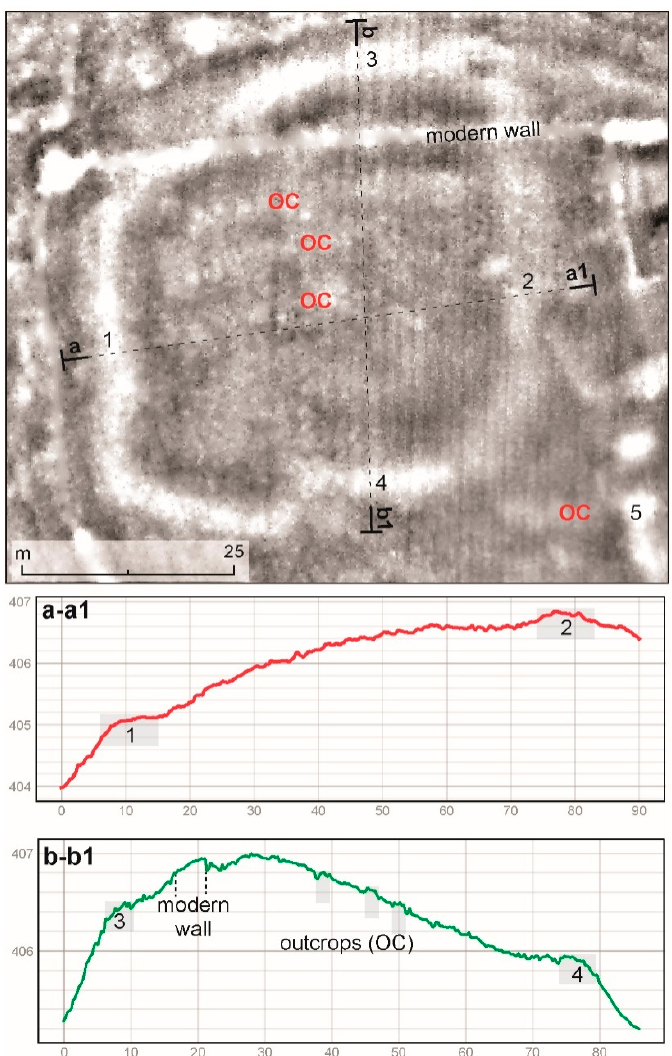
Figure 7. Simple Local Relief Model visualization of feature 10 ( top ) and interpreted profiles ( below ) (radius = 20 px). The dotted lines and associated letters a-a1 and b-b1 indicate the position of the interpreted topographic surface profiles from ALS data.